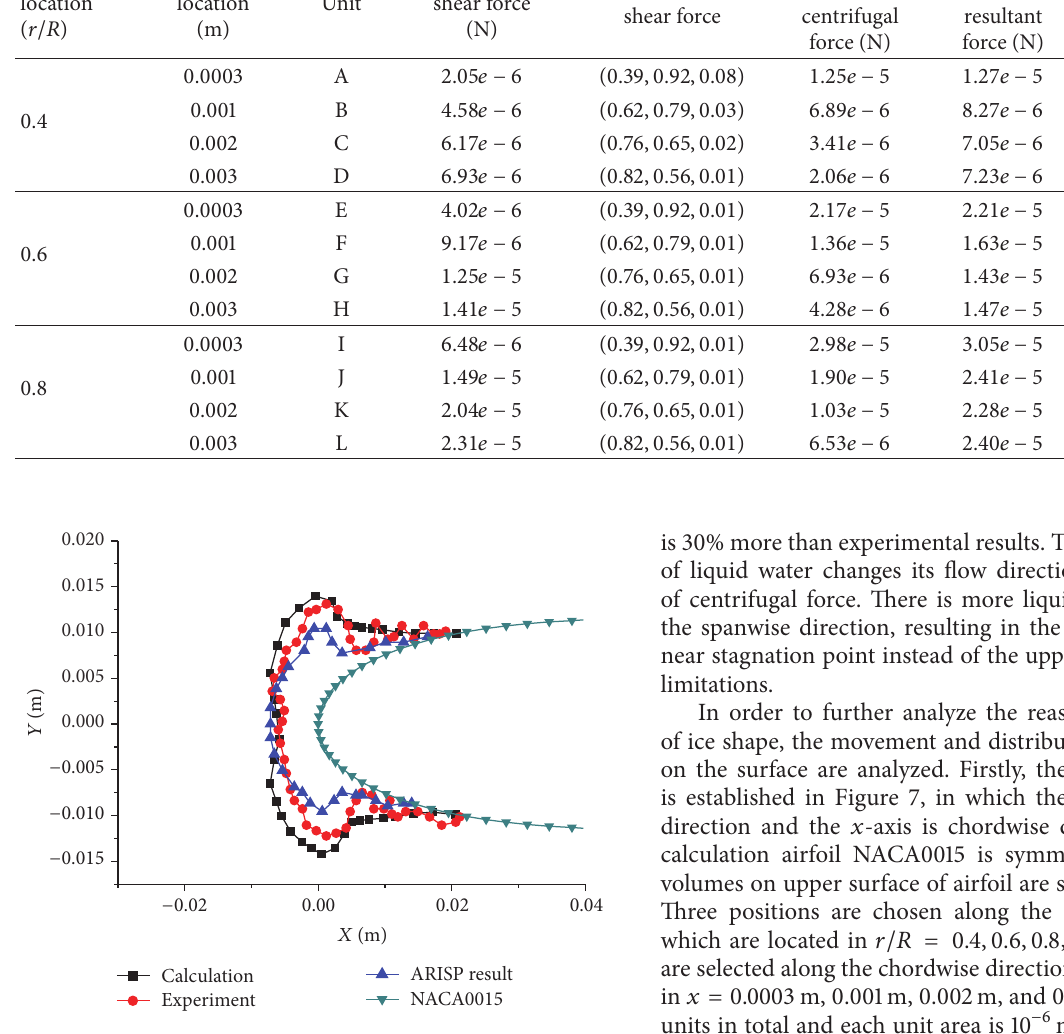
Figure 5: Comparison of rotor blade ice shape in condition